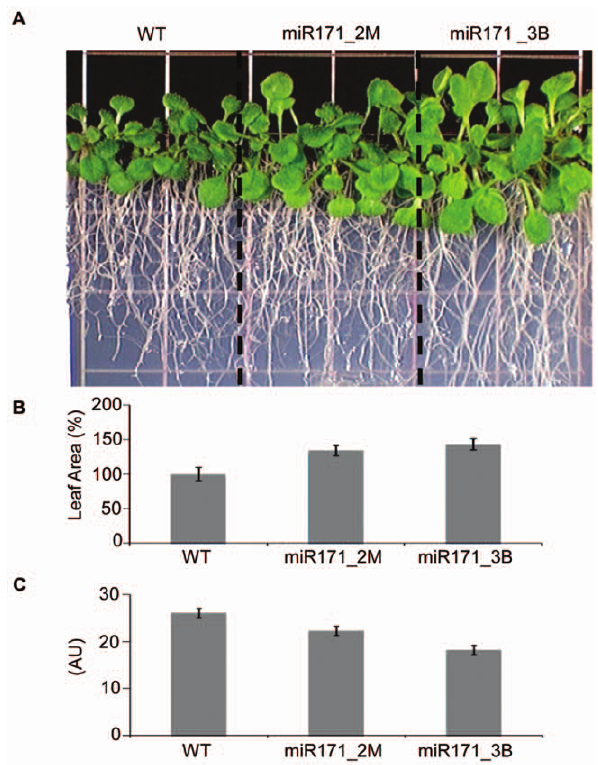
Figure 6. Characteristics of transgenic Arabidopsis over-ex- pressing miR171_2M and miR171_3B decoys. ( A ) Wild type and transgenic plants (T3 generation) expressing miR171_2M and miR171_3B decoys grown on vertical agar plates with M&S media at 25 u C and 16/8 hours day/night. ( B ) Rosette leaf area of wild type and transgenic plants expressing miR171_2M and miR171_3B decoys. Leaves were detached from plants and leaf area measured. Six three week old plants were used per measurement. ( C ) Chlorophyll content of miR171 decoy plants. Chlorophyll content of 3 rosette leaves of 12 plants per event was measured using Minolta SPAD 502 meter.